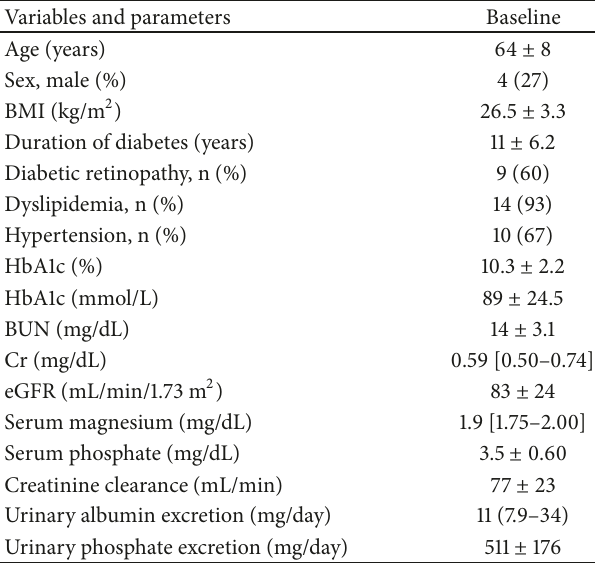
Table 1: Baseline characteristics of